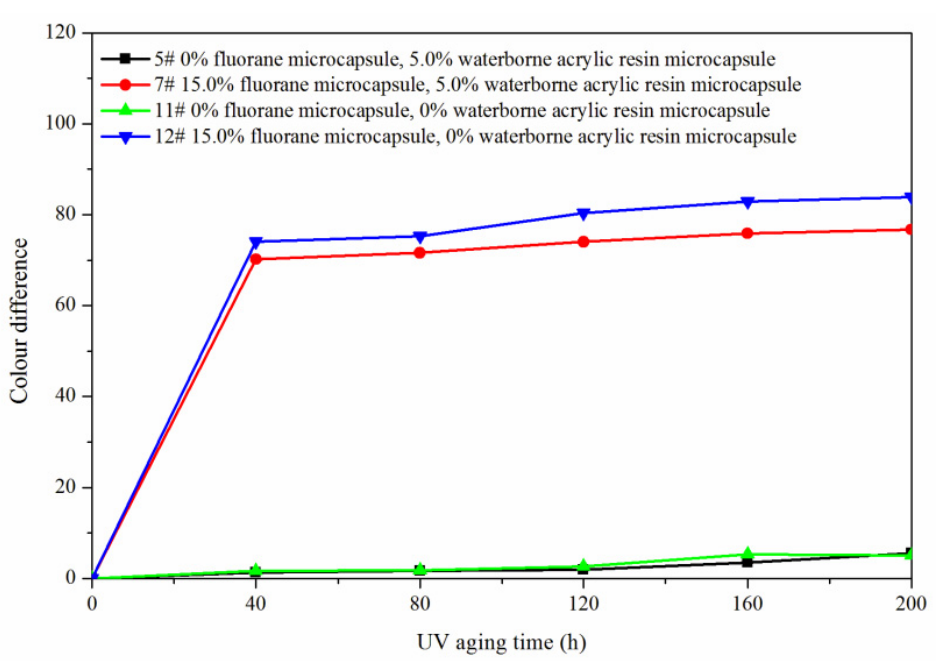
Figure 15. Effect of UV aging time on the color difference of film.